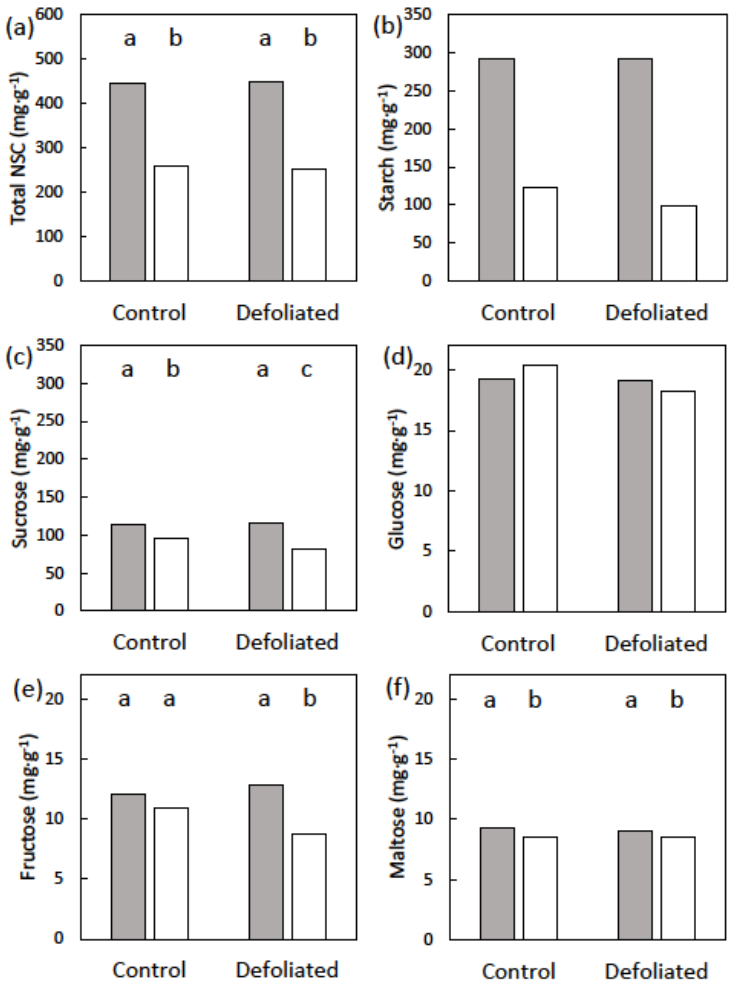
Figure 4. The non-structural carbohydrates (NSC) of Cycas micronesica stem tissues before (gray bars) and after (white bars) the construction of synchronized leaf flush, as influenced by defoliation prior to new leaf growth. ( a ) t = Total NSC; ( b ) starch; ( c ) sucrose ( d ) glucose; ( e ) fructose; and ( f ) maltose. Bars with same letters are not different for NSCs with significant time × treatment effects.